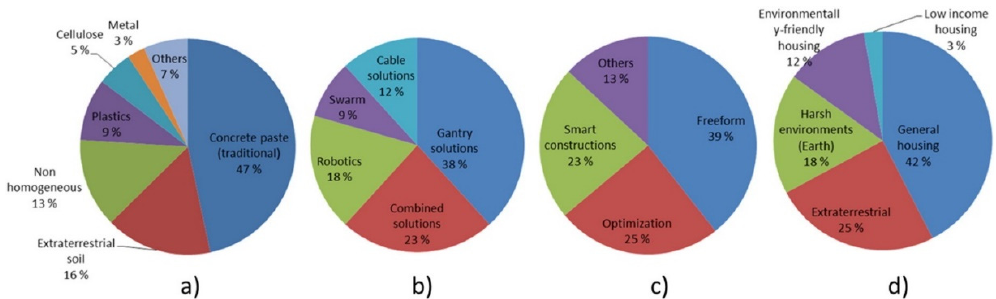
Figure 12. Publications of AM in construction sorted according to number of publications for ( a ) material science, ( b ) engineering, ( c ) architecture, ( d ) relevant markets. Reprinted with permission from ref. [3]. Copyright 2016 Copyright Elsevier B.V.